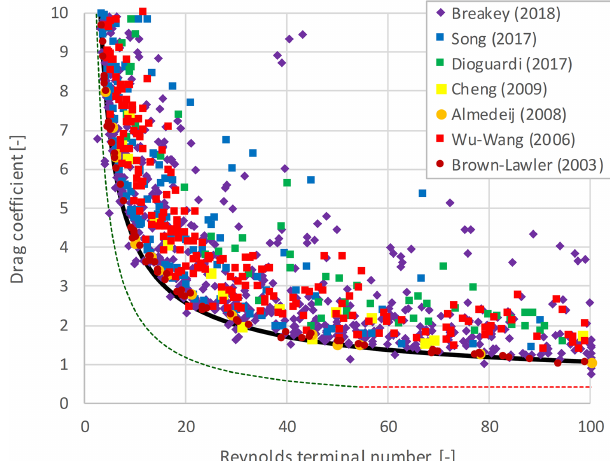
Figure 12. SDC (lin–lin) data from the sources in the literature, magnified in on an area that is important for drinking water treat- ment. Solid lines represent the Brown and Lawler (2003) drag model and dashed lines the Stokes and Newton drag models, re-